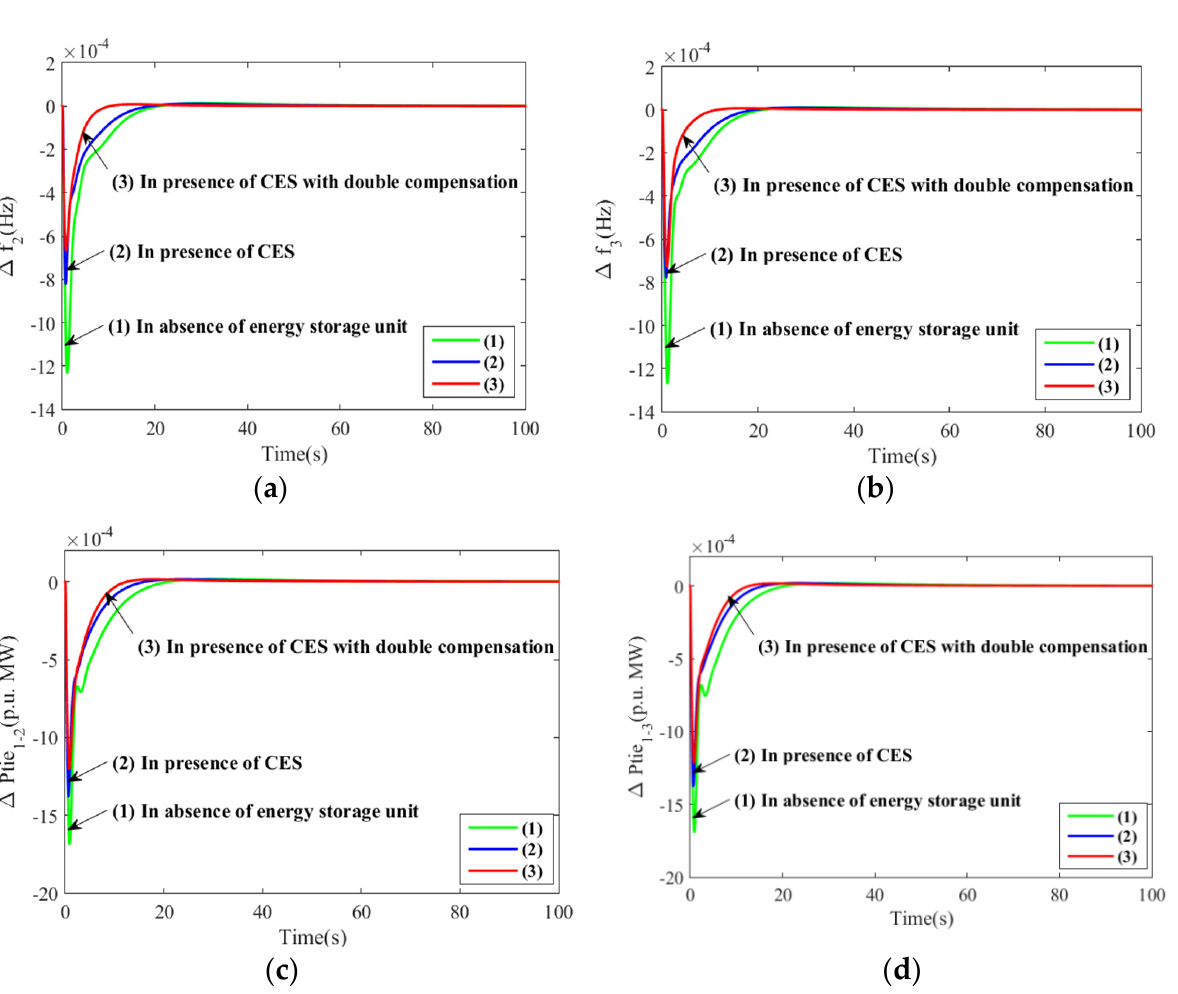
Figure 11. Valuation of influence of C ES with/without duple compensation on scheme dynamics employing SHO-optimized PDN(FOID) controller taking into account 1% step load disturbances for system-5 and system-6 individually contrast time: ( a ) Anomaly of frequency in area-2, ( b ) Anomaly of frequency in area-3, ( c ) Anomaly of Tie-line power interlinking area-1 and area-2, ( d ) Anomaly of Tie-line power interlinking area-1 and area-3.